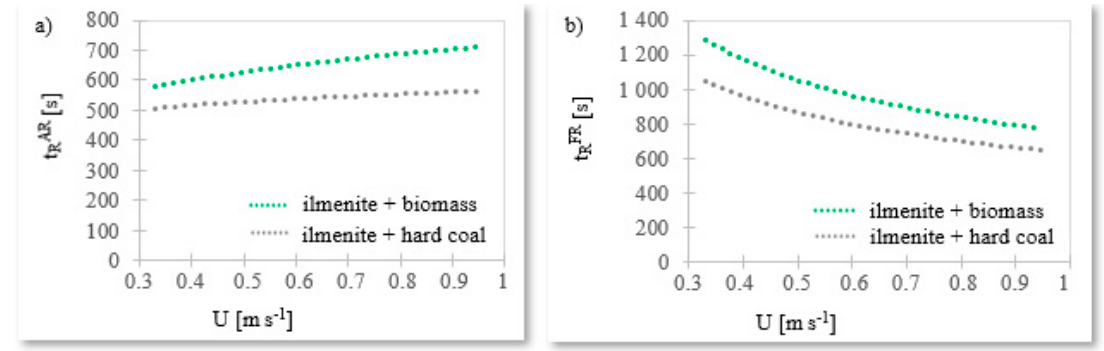
Figure 16. The particles’ residence time in the reactors versus superficial gas velocity in the FR ( a ) AR; ( b ) FR.